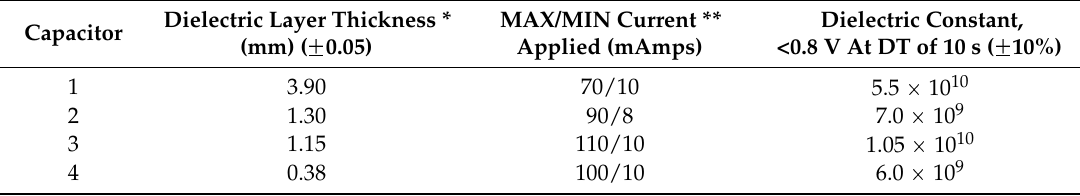
Figure 1. Dielectric constant below 1 volt vs. level of NaCl saturation for fumed silica-based capacitors. The RC time constant method was employed to determine the dielectric constant of fumed silica/aqueous NaCl dielectric materials that differed substantially only in the level of salt concentration. For example, in all cases the dielectric thickness was 2 ± 0.2 mm. Relative saturation computation was based on 100% NaCl saturation at 25 °C: 360 g NaCl/1000 g H 2 O. Table 1. Capacitors tested with Galvanostat.